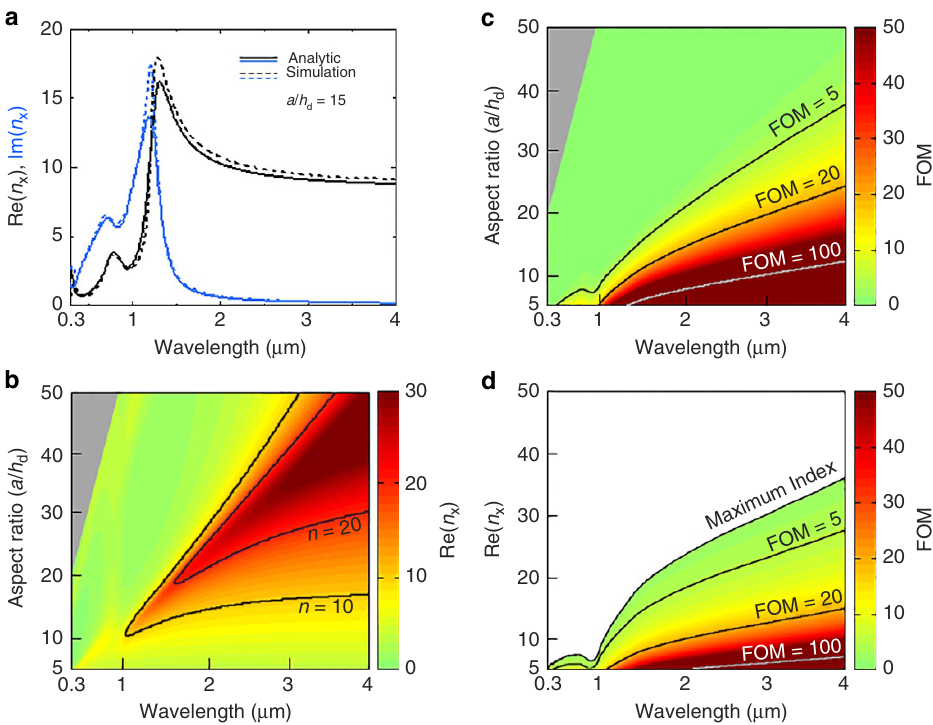
Figure 4 | Effective parameters of the mesocopic crystal at optical frequencies. ( a ) Analytic calculations of the effective index of the proposed mesosopic crystal with quasi-static approximation show good agreement with the refractive index retrieved from the FDTD simulation for the wavelength range of 0.3 to 4 m m. (Black and blue colours indicate the real and imaginary part; Solid and dashed lines indicate results of the analytic calculation and simulation, respectively.) ( b , c ) Wavelength dependent effective refractive index and FOM (Re[ n x ]/Im[ n x ]) for various aspect ratios are shown. Grey coloured area indicates the region for a 4 l o /3; homogenization of mesoscopic crystal may not be valid within this region. ( d ) Achievable range of effective index is plotted as a function of wavelength. Maximum achievable effective index drops as the wavelength increases; however, an effective index close to 15 can be obtained for a wavelength of 1.55 m m with an FOM of